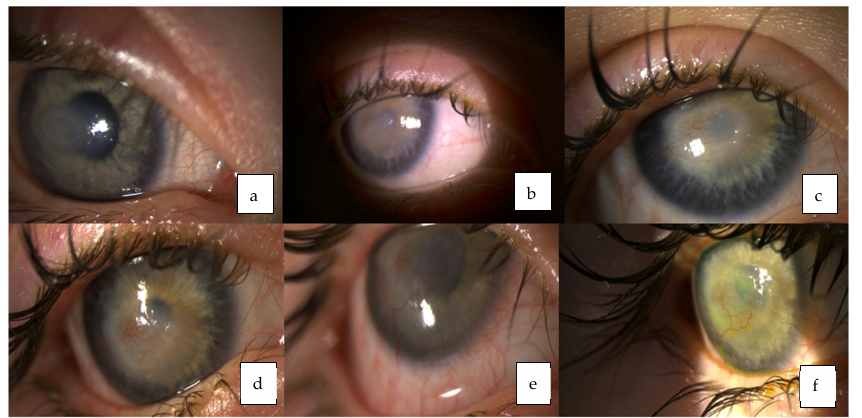
Figure 1. Dynamic of the right eye corneal ulcer: ( a ) Corneal ulcer. ( b ) Right eye after amniotic membrane transplantation. ( c – e ) Corneal opacity and neovascularization. ( f ) Right eye after anti-VEGF subconjunctival injection.